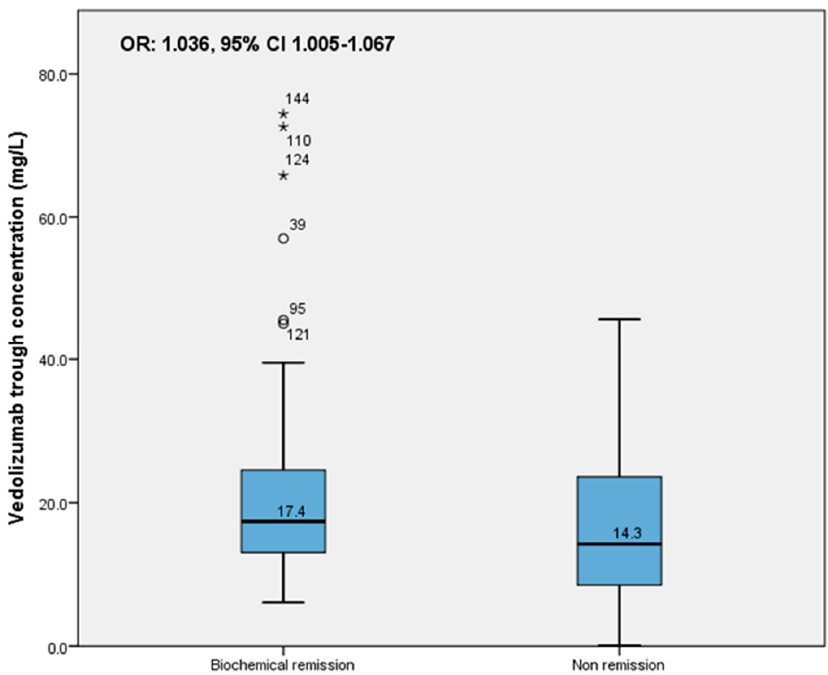
Figure 2. Association of trough concentration with biochemical remission in total IBD group. (° indicates an outlier in the dataset, * indicates there is an extreme outlier in the dataset).